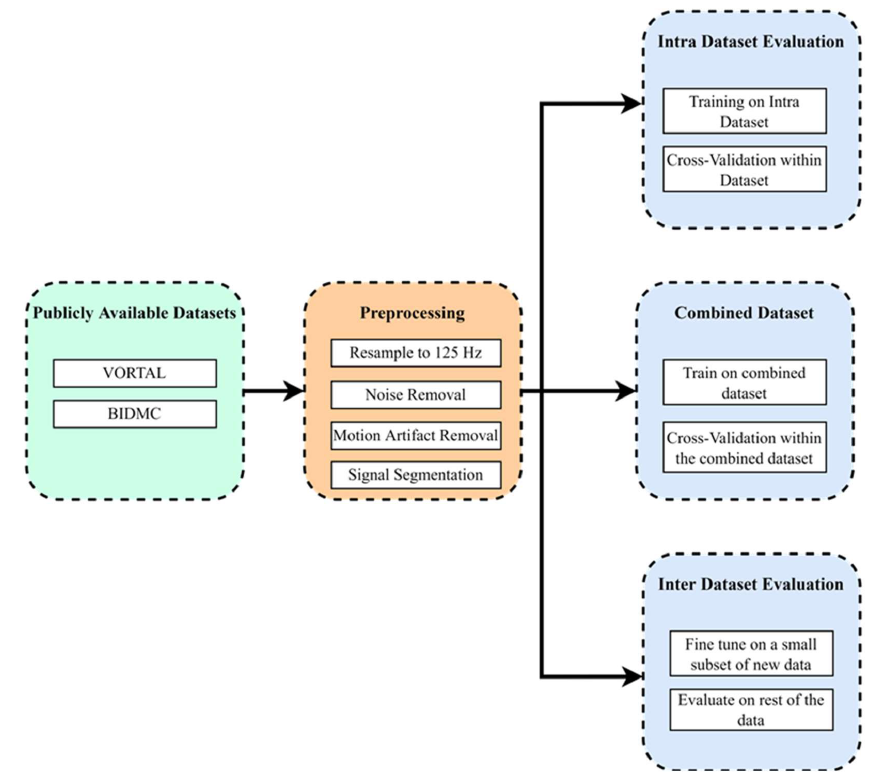
Figure 1. Overview of the methodology of this work.